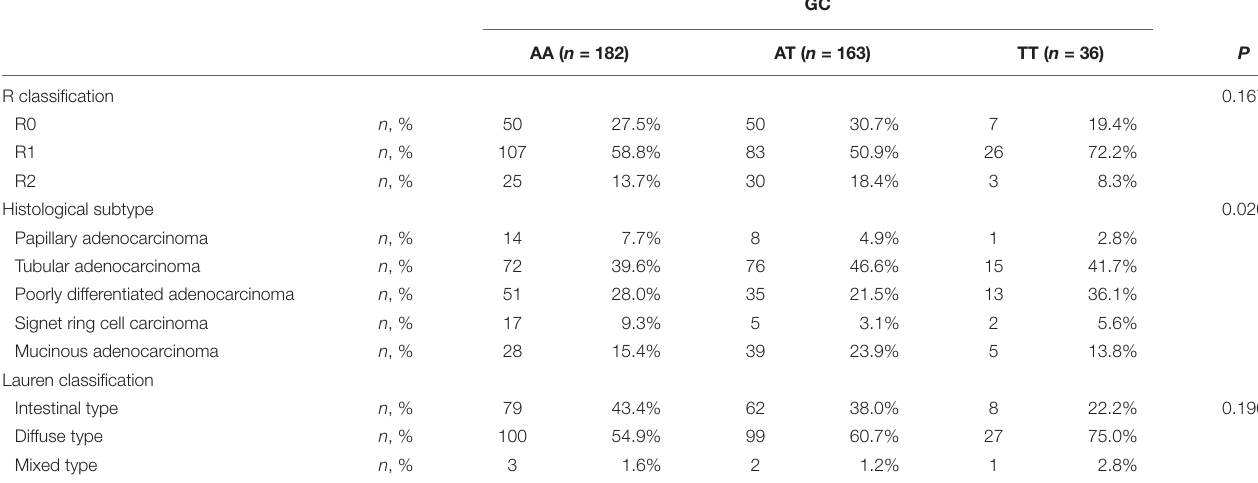
TABLE 4 | Comparison of studied data according to AURKA genotypes in all GC